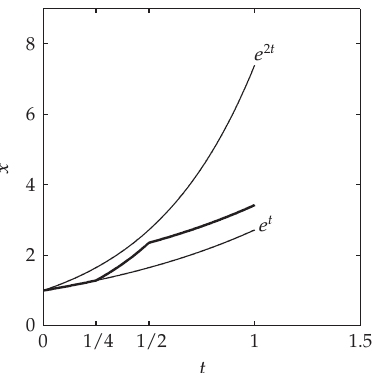
Figure 3: The solution of the di ff erential inclusion that corresponds to two switchings: from k (cid:7) 1 to k (cid:7) 2 at the moment t (cid:7) 1 / 4 and from k (cid:7) 2 to k (cid:7) 1 at the moment t (cid:7) 1 / 2